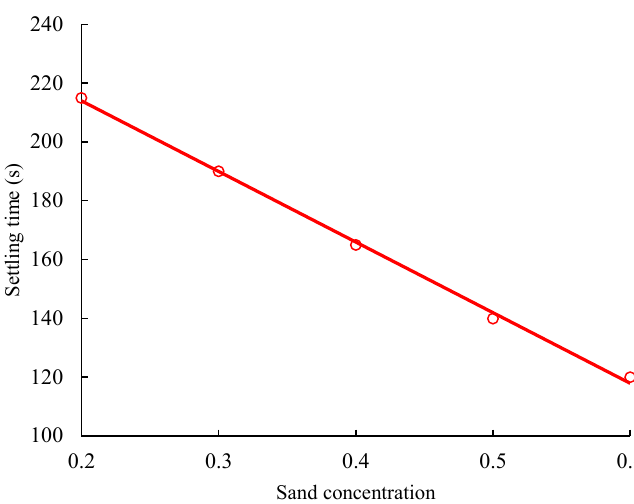
Figure 10. Settling time at different sand concentrations.